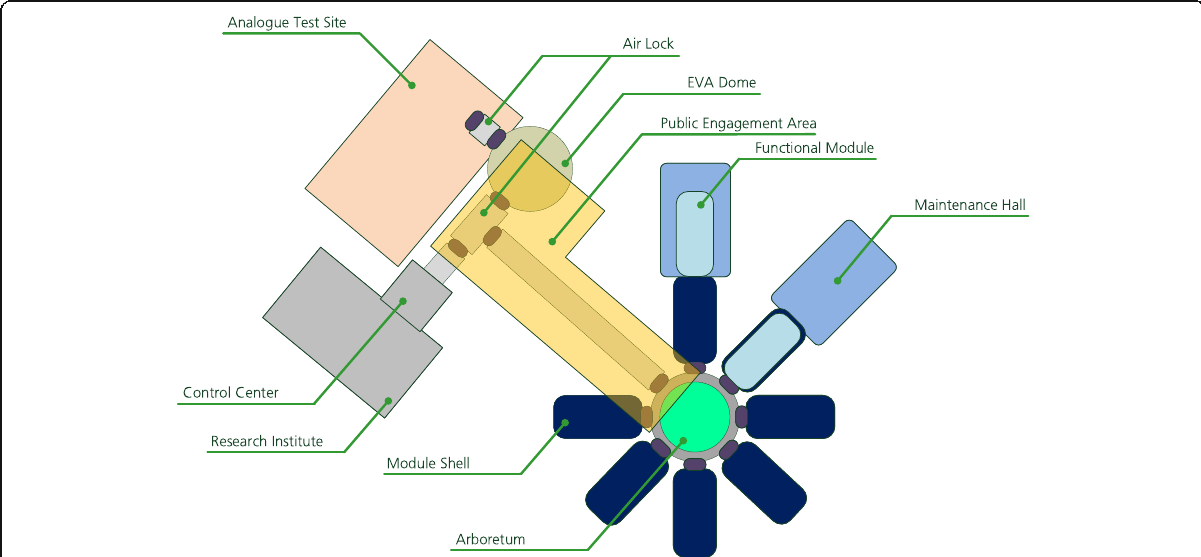
Fig. 2 Schematic view of the Incubator with all relevant elements. Functional modules (e.g. for air management) are contained (air-tight) within module shells. For exchange of equipment they can be extended into maintenance halls. An overarching public engagement area allows view of major operations, e.g. in the dome. The outside is connected via air-locks to maintain a closed-loop. An EVA dome allows simulation of “ on surface ” operations, an analogue test site links the operation to e.g. robotic